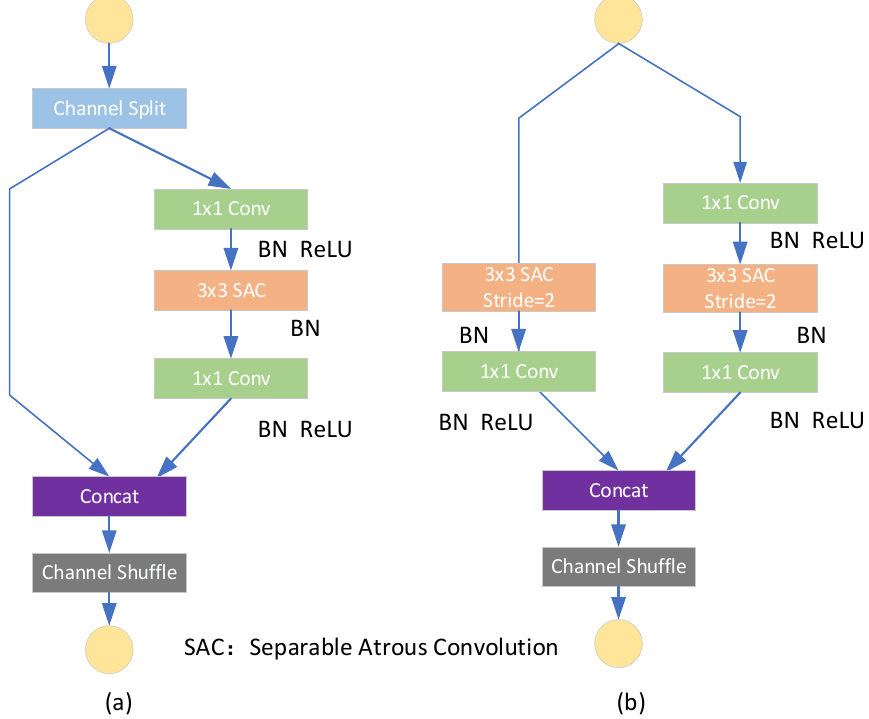
Figure 3. Building blocks of MSF-SNET. ( a ) SDU: spatial downsampling (2x) unit; ( b ) BU: basic building unit. Table 2. Parameters and computing cost for MSF-SNET.